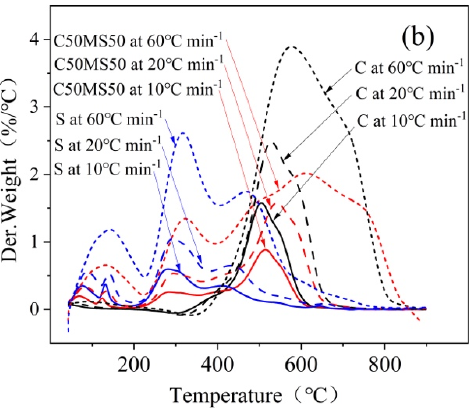
Figure 3. TG ( a ) and DTG ( b ) curves of coal, municipal sludge and C50S50 at different heating rates of 10, 20 and 60 °C/min.